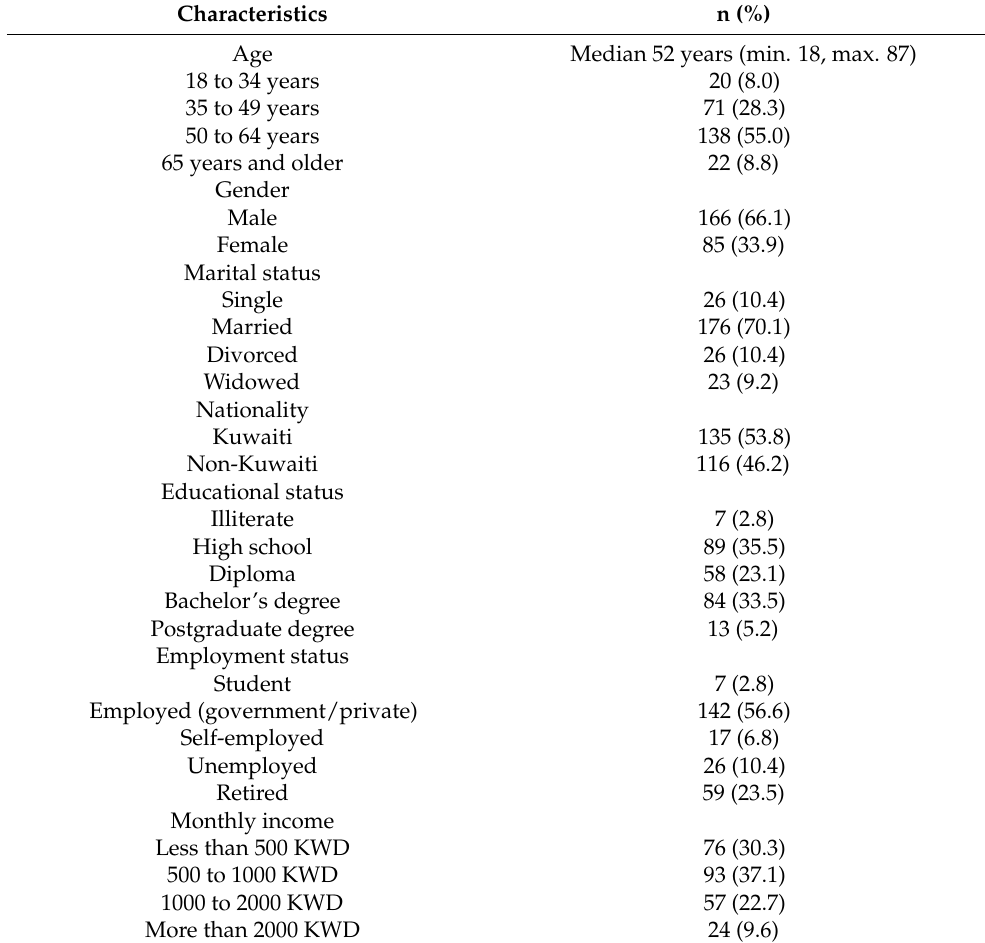
Table 2. Patients’ demographics (n =